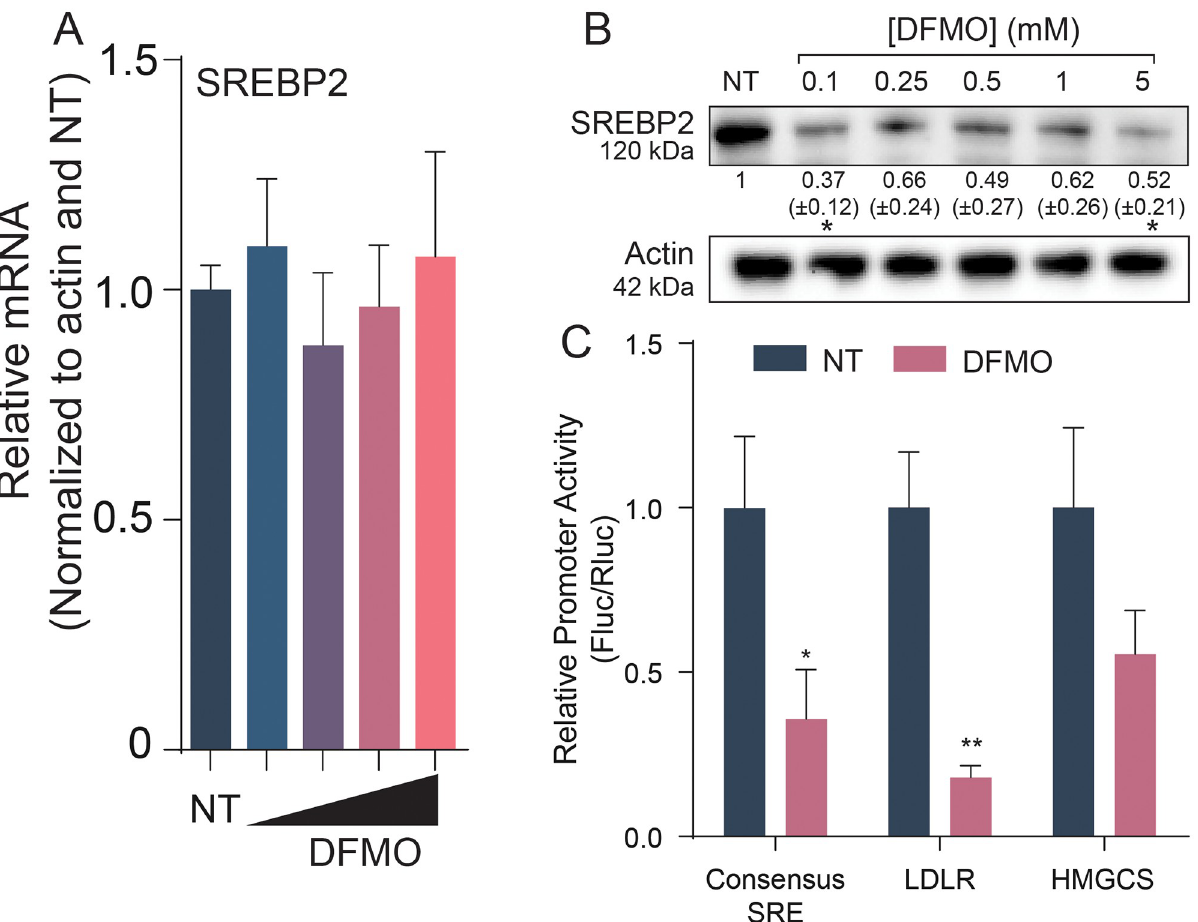
Fig 4. SREBP2 synthesis is dependent on polyamines. (A) Normalized qPCR of SREBP2 with increasing doses of DFMO (0.1, 0.5, 1, 5mM) relative to actin expression in Huh7 cells. (B) Western blot of SREBP2 in DFMO treated Huh7 cells. Actin was used as a loading control. (C) Huh7 cells were treated with 1mM DFMO for 96h followed by transfection with the promoter luciferase constructs and renilla luciferase transfection controls. Results are normalized to no treatment (NT) and are relative to renilla activity. * p < 0.05 and ** p < 0.01 by two-way ANOVA. Data from at least three independent